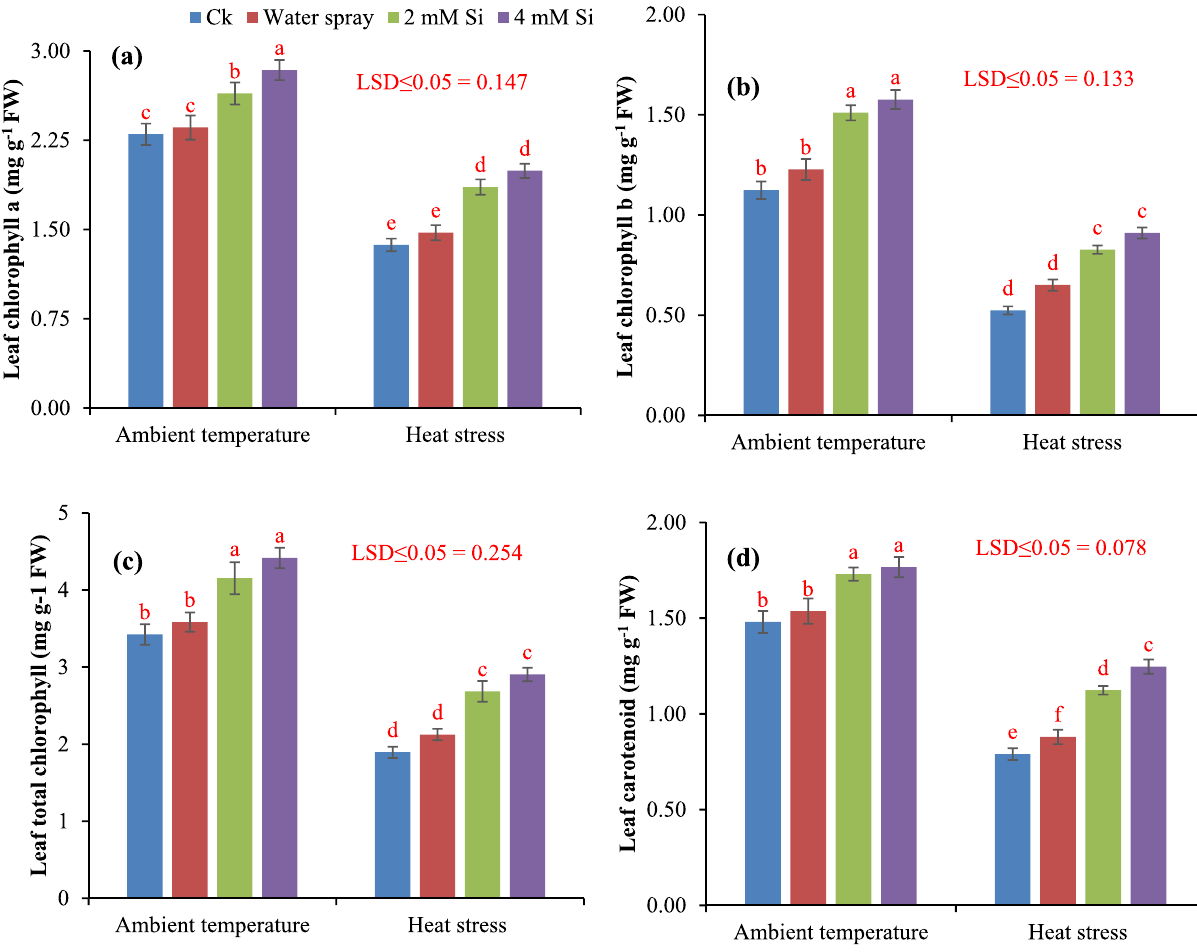
Figure 3. Influence of exogenously applied Si on chlorophyll a ( a ), chlorophyll b ( b ), total chlorophyll ( c ) and carotenoid ( d ) of wheat under ambient temperature and heat stress. Values are the mean SE of four